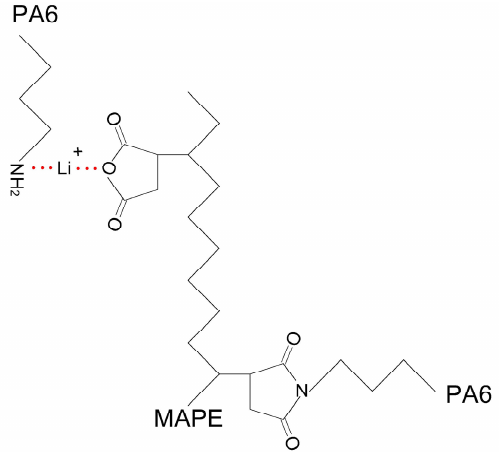
Figure 7. Scheme of complexation between LiCl and O or N.